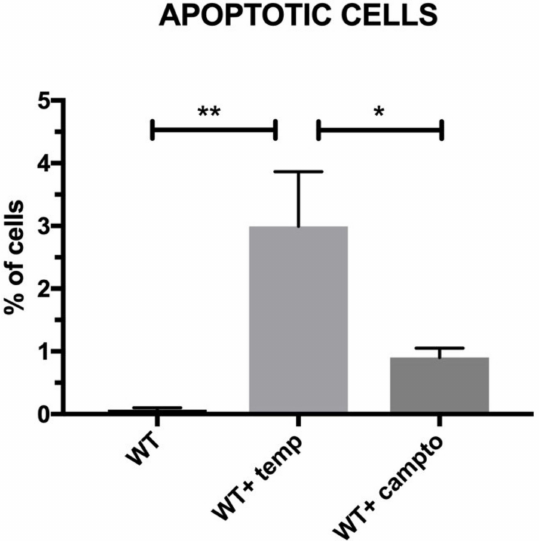
Figure 8. Induction of necrosis/apoptosis by two different treatments of wild type (WT) SkM cells, n = 3. Some samples were treated by temperature 90 ◦ C/10 min and the other with camptothecin. Statistical significance has been shown: p < 0.05 (*), p < 0.01 (**), p < 0.001 (***). Results were performed using the one-way ANOVA